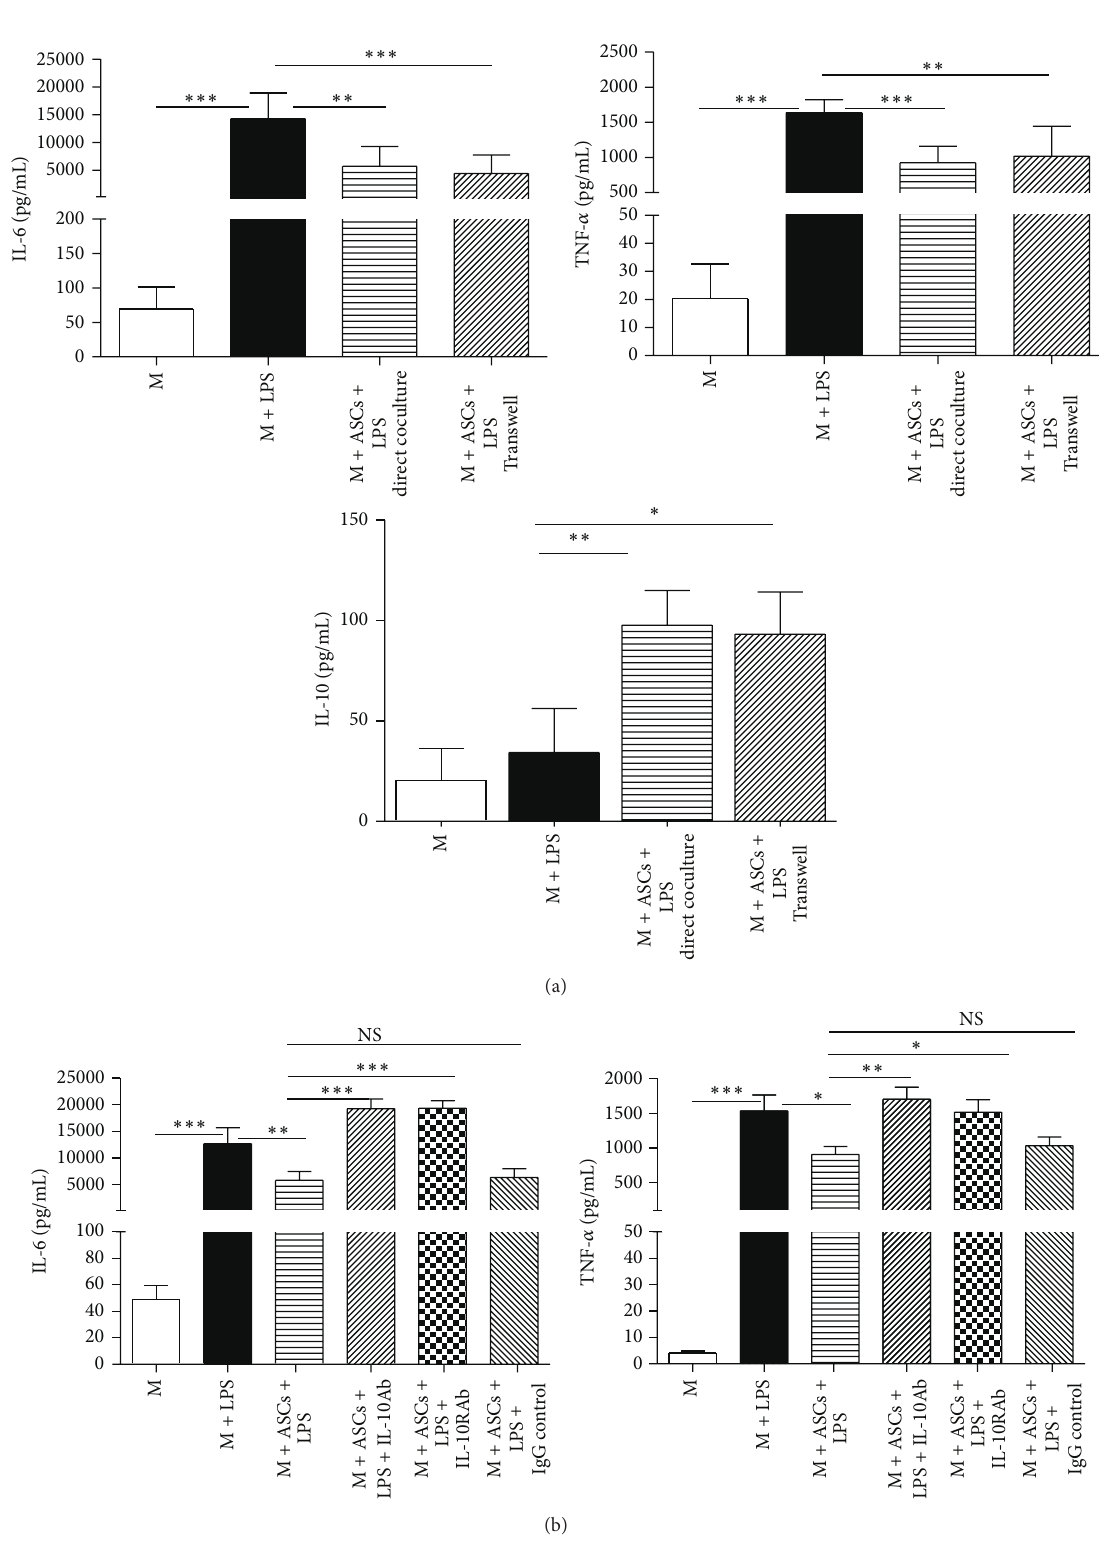
Figure 6: ASCs and IL-10 regulate the profile of cytokines produced by macrophages (M). (a) M (2 × 10 6 cells/well) were cultured alone, cocultured directly with ASCs, or cocultured with ASCs via Transwell (M: ASCs ratio = 4 :1) for 48 h. Cells were then washed and incubated for 24 h with fresh culture medium with or without LPS (10ng/mL). (b) Neutralizing IL-10 antibody (IL-10Ab, 10ng/mL), IL-10 receptor antibody (IL-10RAb, 10ng/mL), or IgG control (10ng/mL) was added to the medium at the beginning of the Transwell cocultures of ASCs + M. Then, cells were treated with or without LPS (10 𝜇 g/mL) for another 24 h. Culture supernatants were harvested for cytokine assay via Luminex. All data are expressed as mean ± SEM; 𝑛 = 4 per group. ∗ 𝑝 < 0.05 ; ∗∗ 𝑝 < 0.01 ; and ∗∗∗ 𝑝 < 0.001